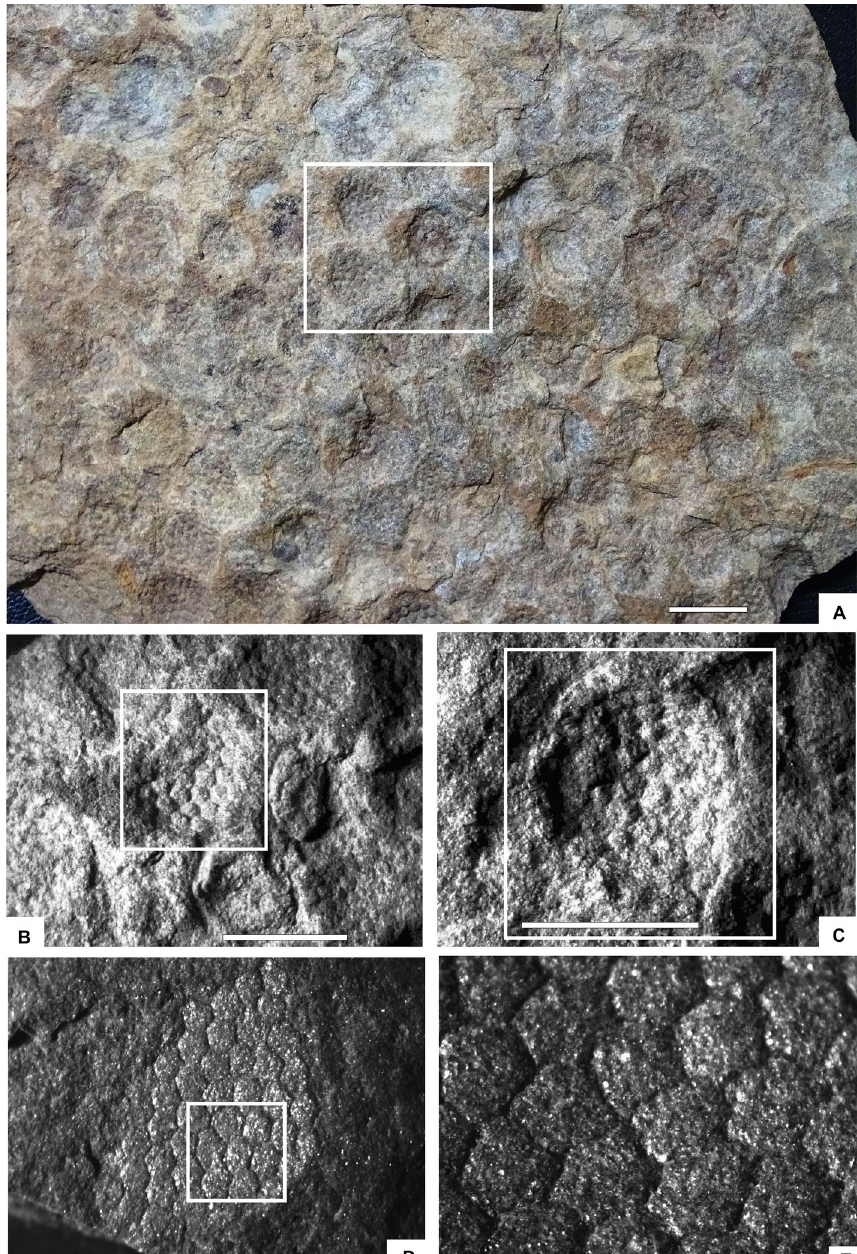
Fig. 5. Dasycladaceae algae Cyclocrinites sp. ( A – E ) from the Takche Formation, Gechang locality, Parahio Valley, Spiti, Himalaya. B, magnification of A; C, magnification of B; E, magnification of D. All scale bars = 1